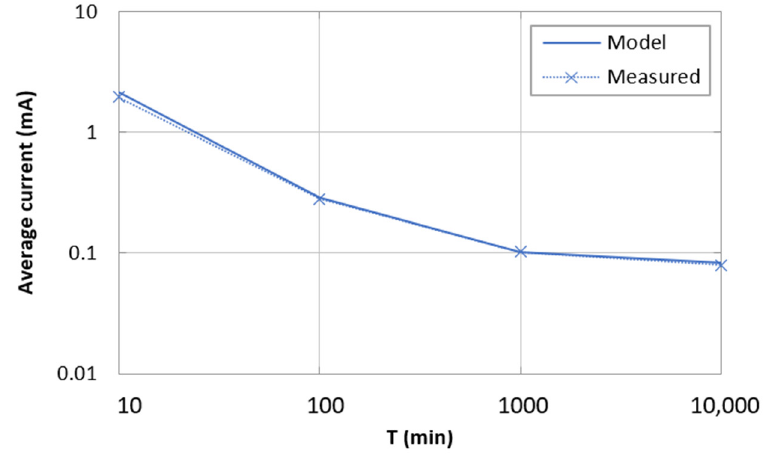
Figure 8. Average current consumption as a function of T: model ( p = 0) vs. measured results.